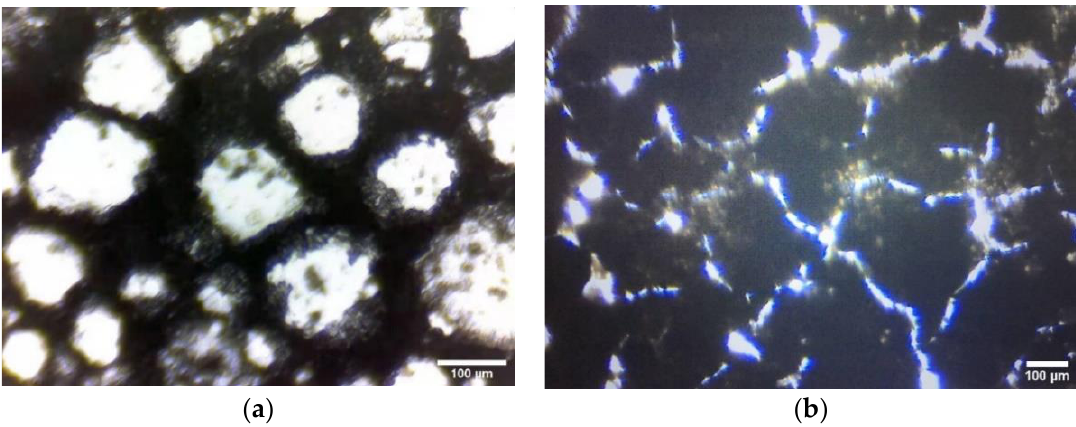
Figure 15. Microscopic pores of SCGPCS. ( a ) Cross-section. ( b ) Longitudinal section.